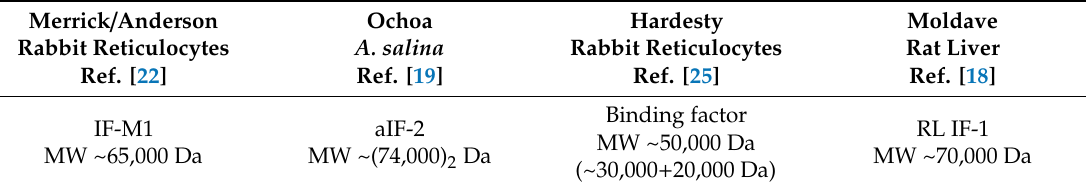
Table 1. Eukaryotic factors initially identified to be capable of binding Met-tRNA i to the 40S subunit. Merrick / Anderson Rabbit